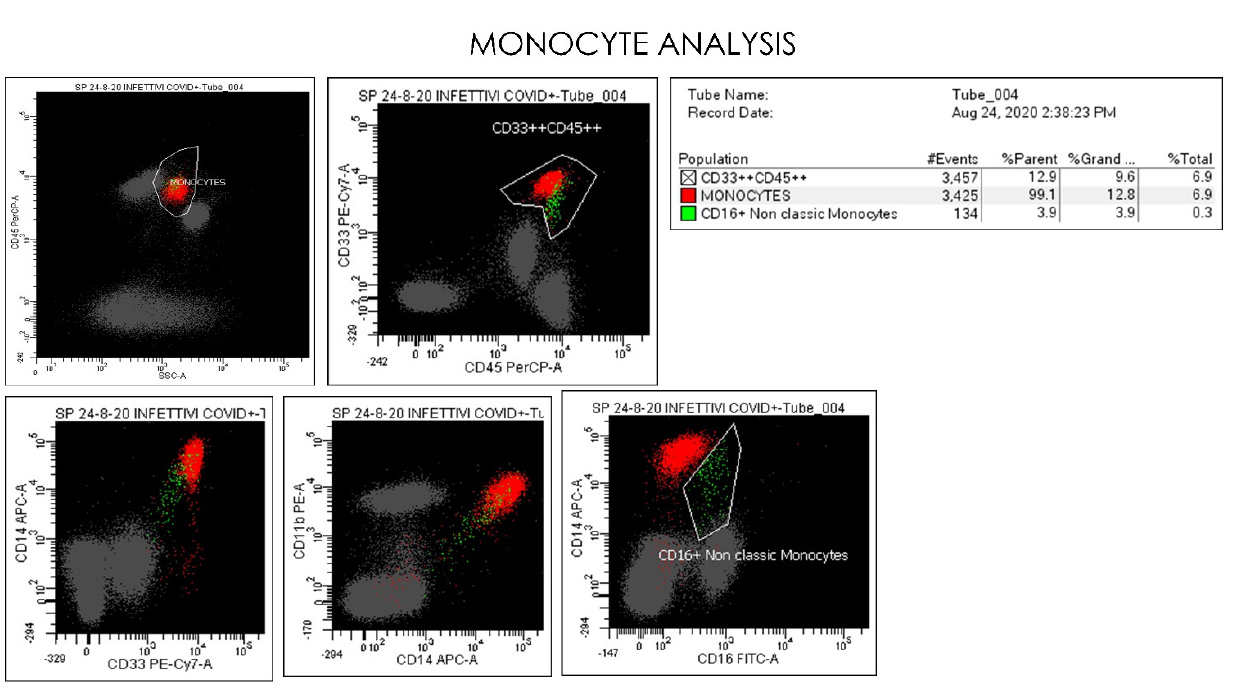
Figure 12. Gating Strategy for Lymphocytes, CD4 naïve, CD8 naïve, T reg, CD3+CD8+ quantification. A doublet exclusion gate based upon (FSC-A vs. FSC-H) was utilized to gate on singlet cells, and within this singlet cell gate a lymphocyte gate was drawn in a dot plot of FSC-A vs. SSC-A. Dot plots of CD3 and CD45 on the X-axis vs. CD33, CD45, CD16, CD56, and CD14. The instruments were set using one set of target values as described in “Method”. Percentages of positive cells were determined after gating on CD45 positive cells following the doublet exclusion.